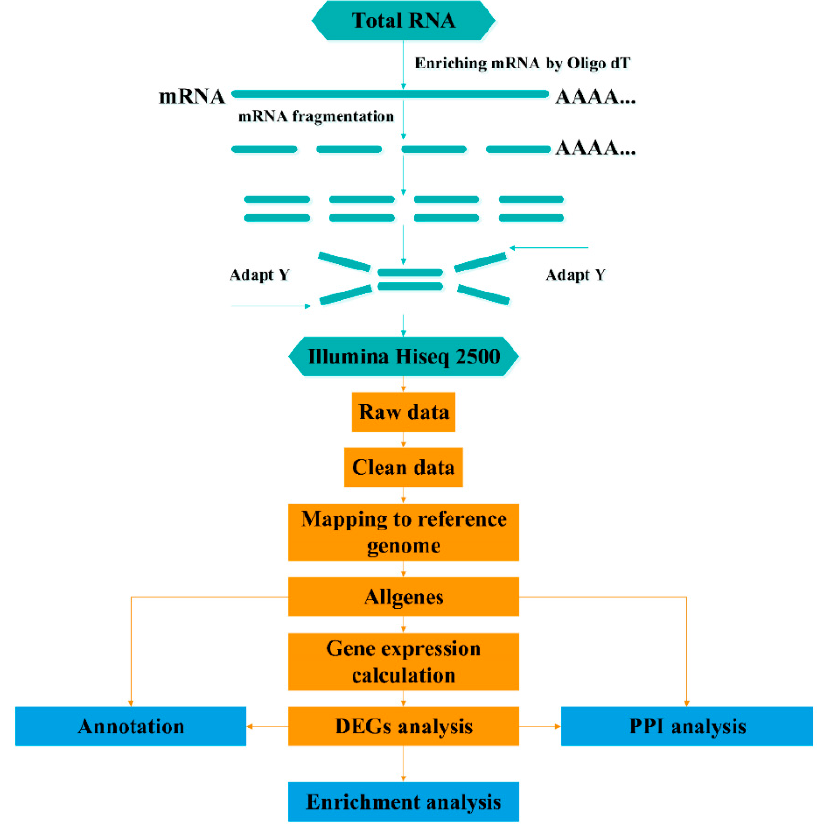
Figure 1. RNA-Sequencing data processing and analysis workflow.